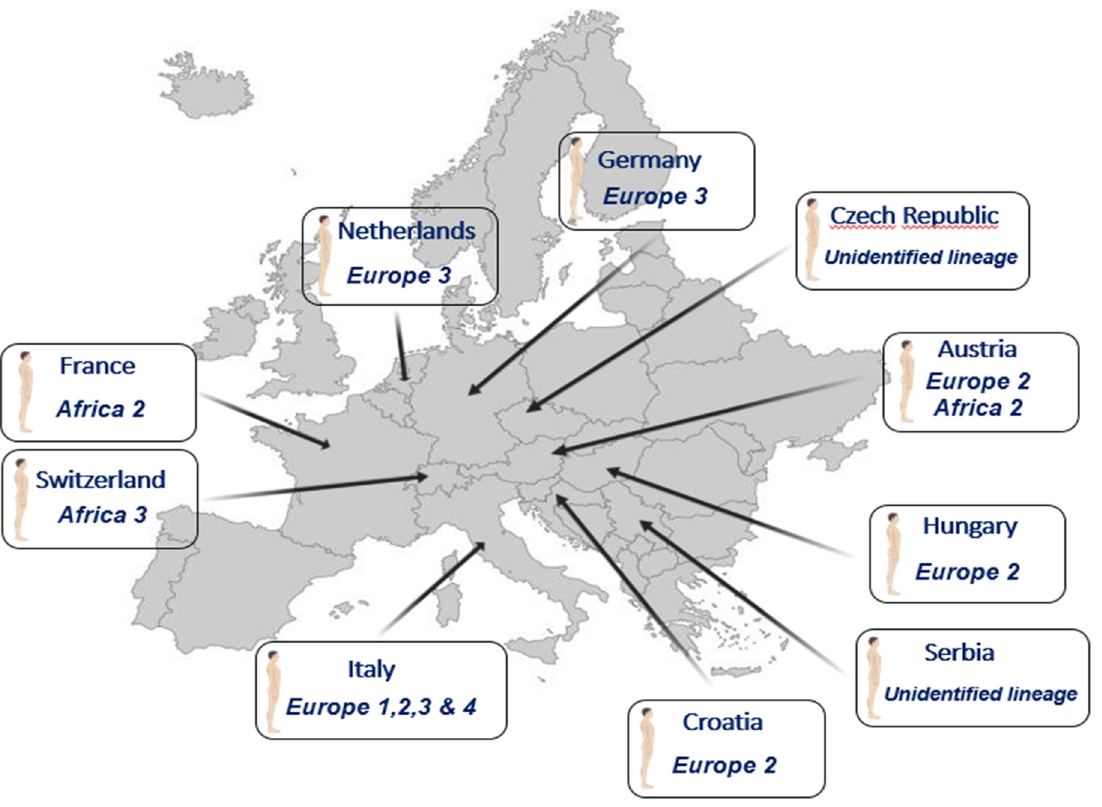
Figure 3. Human cases of Usutu virus infection and the lineages involved.